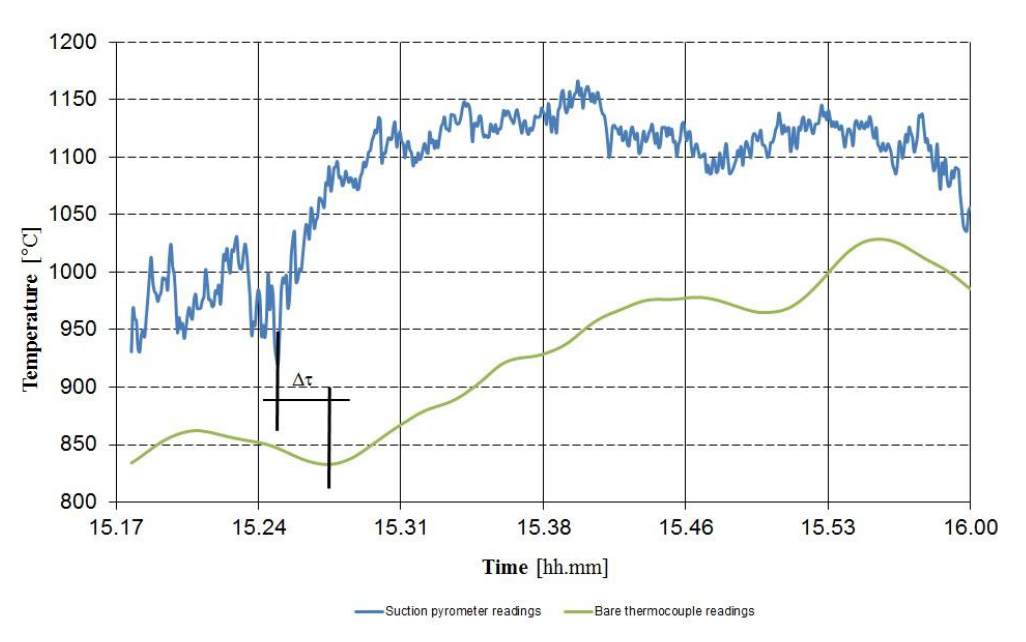
Figure 8. A comparison between suction pyrometers and thermocouple temperature readings in a WTE boiler under unsteady state conditions; a rough evaluation of the difference in the response times of the two thermometers is